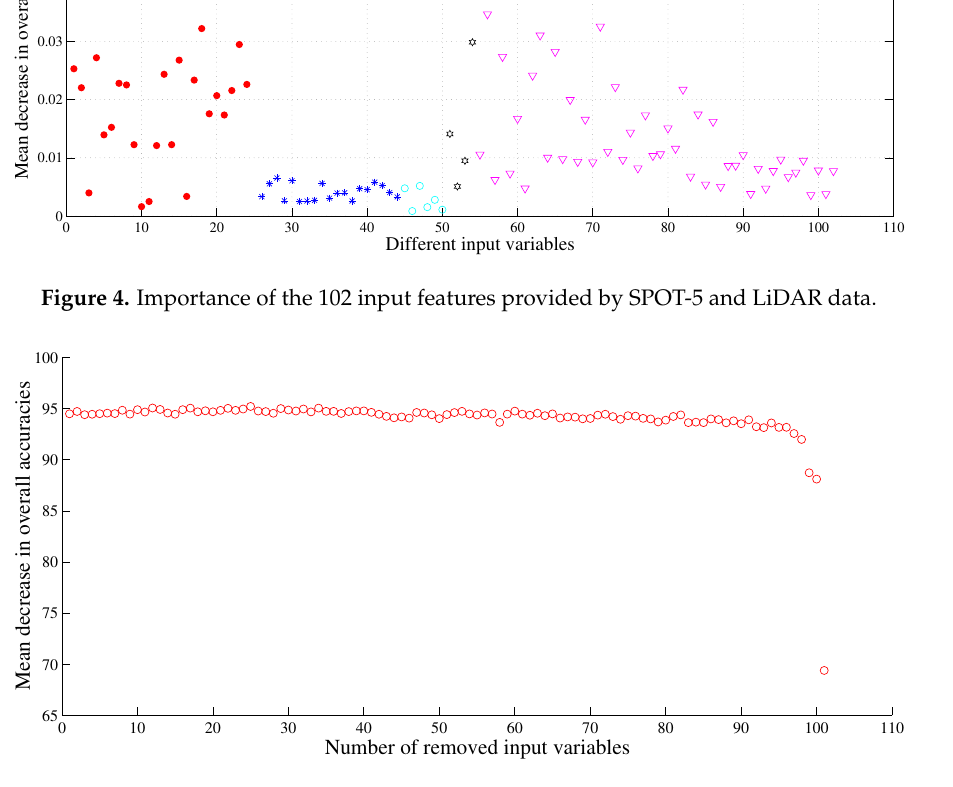
Figure 5. Overall classification accuracies in the basis of backward exclusion of the least important input